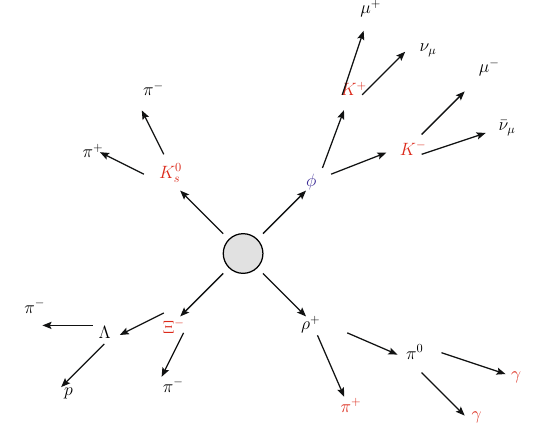
Fig. 3 Visualization of the experimental primary particle definition by Alice [17], with primary particles in red, particles not considered primaryinblackandresonanceswhichcanpossiblybeaddedinaddition to primary particles in blue